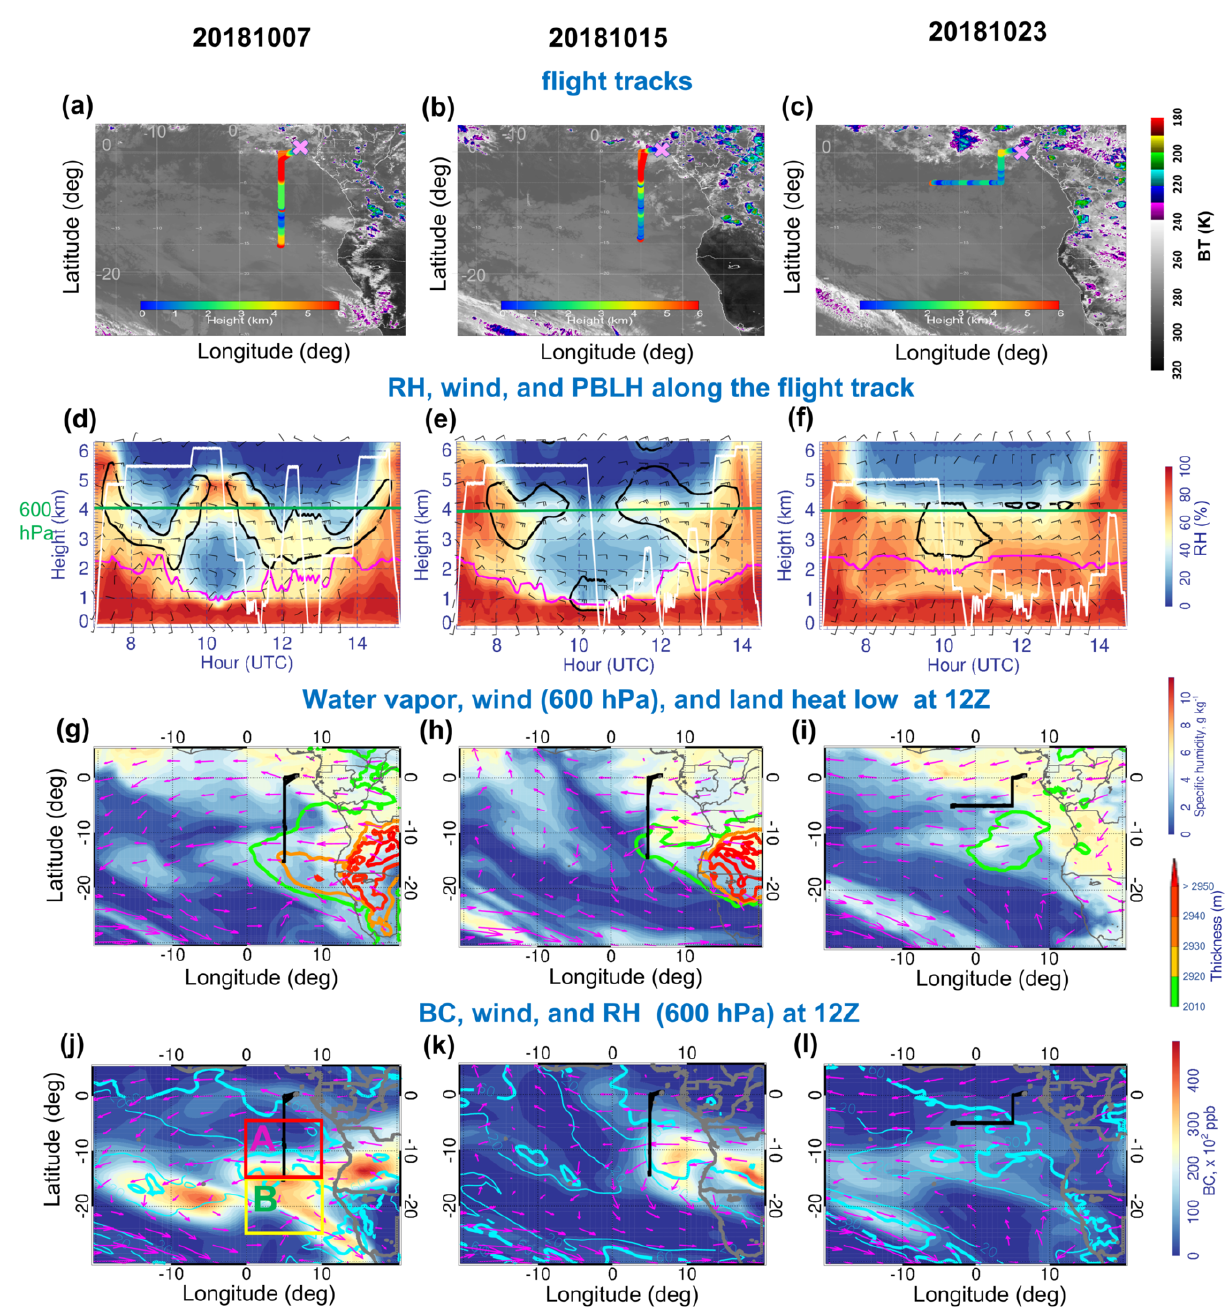
Figure 13. (a–c) The horizontal flight tracks during October 2018 ORACLES deployment plotted on Meteosat IR 10.8µm imagery at 13:45UTC (shading is the brightness temperature (BT); K). The color of the flight track represents the altitude of the flight along the horizontal flight track. (d–f) Curtain plot of RH along the flight track during 7, 15, and 23 October 2018. The white contour represents the flight profile. The magenta line in panels (d) – (f) represents the BLH along the P-3 flight track. Bold black contours in panels (d) – (f) are zonal wind ( − 8ms − 1 ). The green line in panels (d) – (f) indicates the 600hPa level. (g–i) Map of 600hPa q (color shading; gkg − 1 ) and 600hPa horizontal winds (vectors; ms − 1 ) overlaid by heat low (thickness is the geopotential height ( Z ) difference between 600 and 850hPa; color line contour; high values ( > 2920m) over land represent the heat low) at 12:00UTC on 7, 15, and 23 October 2018, respectively. (j–l) Map of 600hPa BC (shading; ppb × 100) overlaid by 600hPa RH (thick cyan line is 60; thin cyan line is 20; %) and 600hPa horizontal winds (vectors; ms − 1 ) at 12:00UTC on 7, 15, and 23 October 2018. The black line in panels (g) – (l) represents the horizontal flight track on the given day. The magenta (yellow) box in panel (j) refers to region A at 0–10 ◦ E, 5–15 ◦ S (region B at 0–10 ◦ E, 15–25 ◦ S).